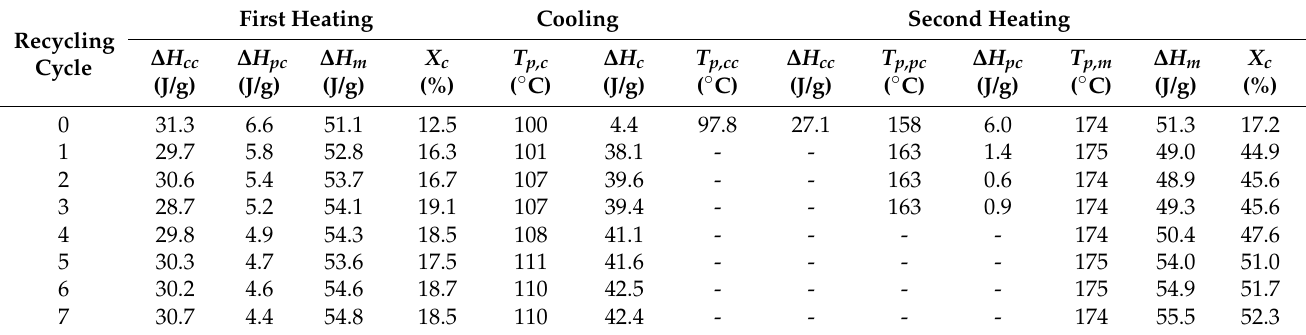
Table 2. Thermal properties and crystallinity degree of PHBV as a function on the number of recycling cycles. Recycling